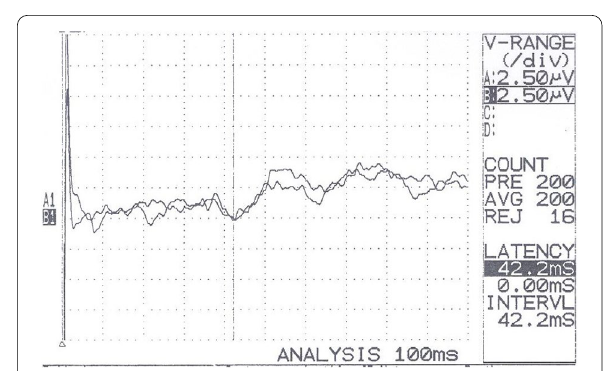
Fig. 4 Somatosensory-evoked potential of the posterior tibial nerve showing a prolonged latency P40 (42.2 ms) cut-off value of 39.25